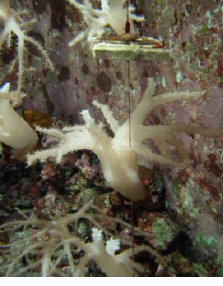
Figure 1. The cultured soft coral S. flexibilis and the structure of flexibilisquinone ( 1